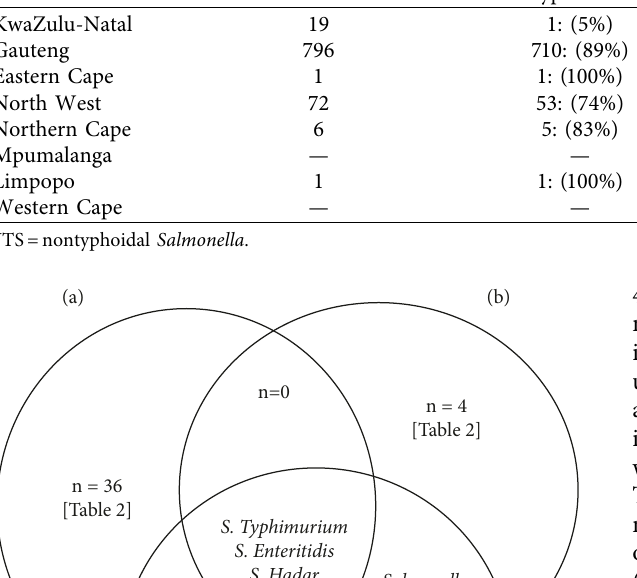
Table 4: Published articles of occurrence of nontyphoidal Salmonella from human, environment, and animals. Province